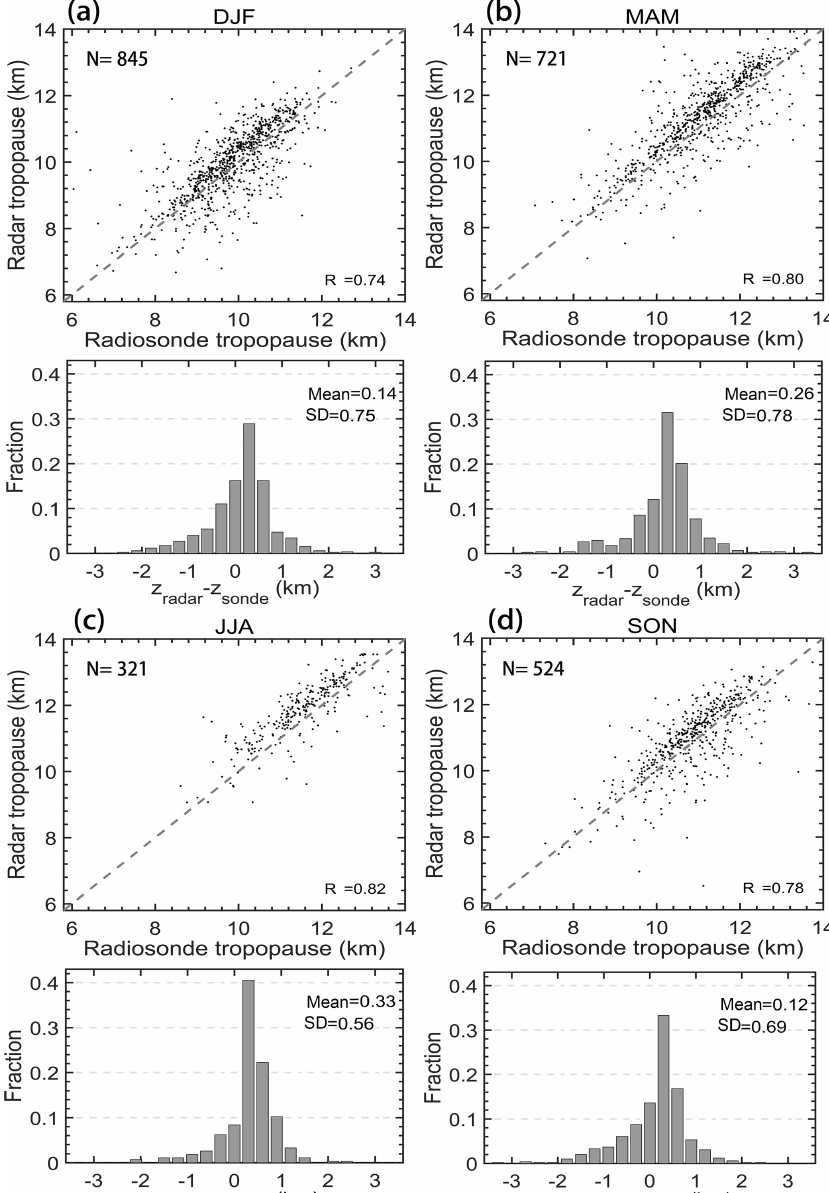
Figure 4. Seasonal scatterplots of the RT versus LRT, and histogram distribution of altitude differences between the RT and the LRT, for (a) winter (DJF), (b) spring (MAM), (c) summer (JJA), and (d) autumn (SON) during the period November 2011–May 2017. The positive values in the histogram indicate the RT being located at a higher level than the LRT. The grey dashed line shows the 1 : 1 line. Here, N , R 2 , mean, and SD indicate the sample numbers, correlation coefficient, mean difference, and standard deviation of the difference,